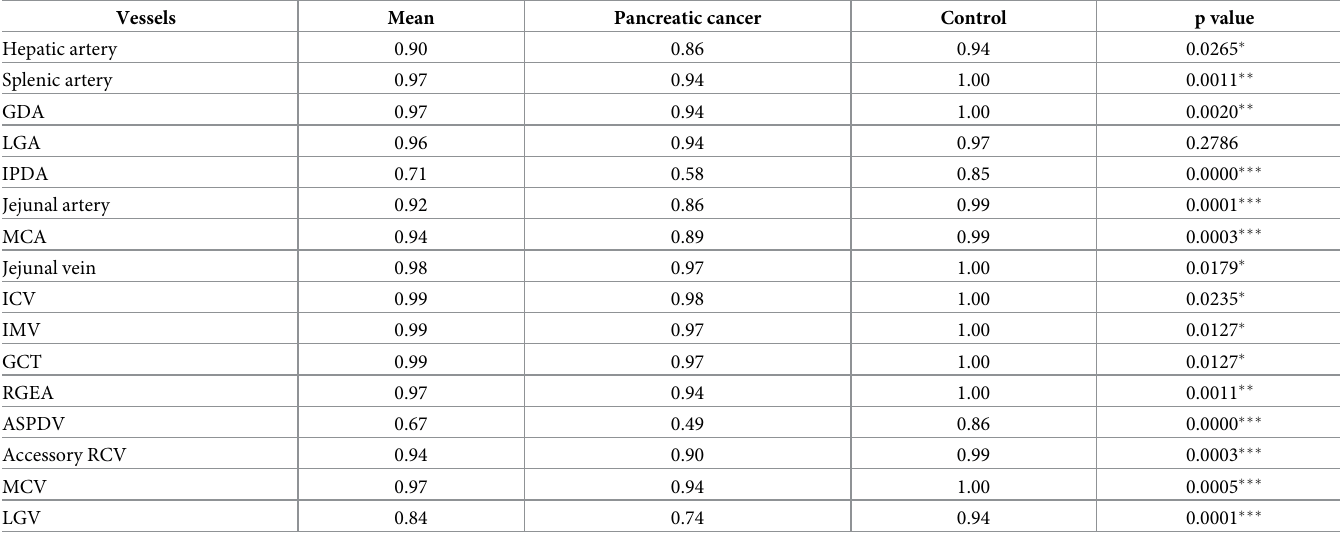
Table 3. The sensitivity for peripancreatic vascular extraction in the two groups.